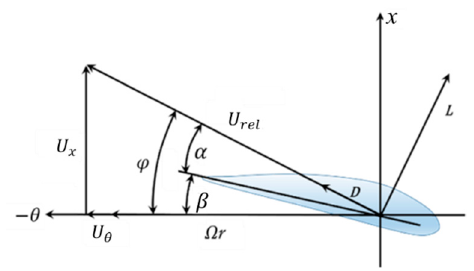
Figure 1. A cross-sectional blade element.